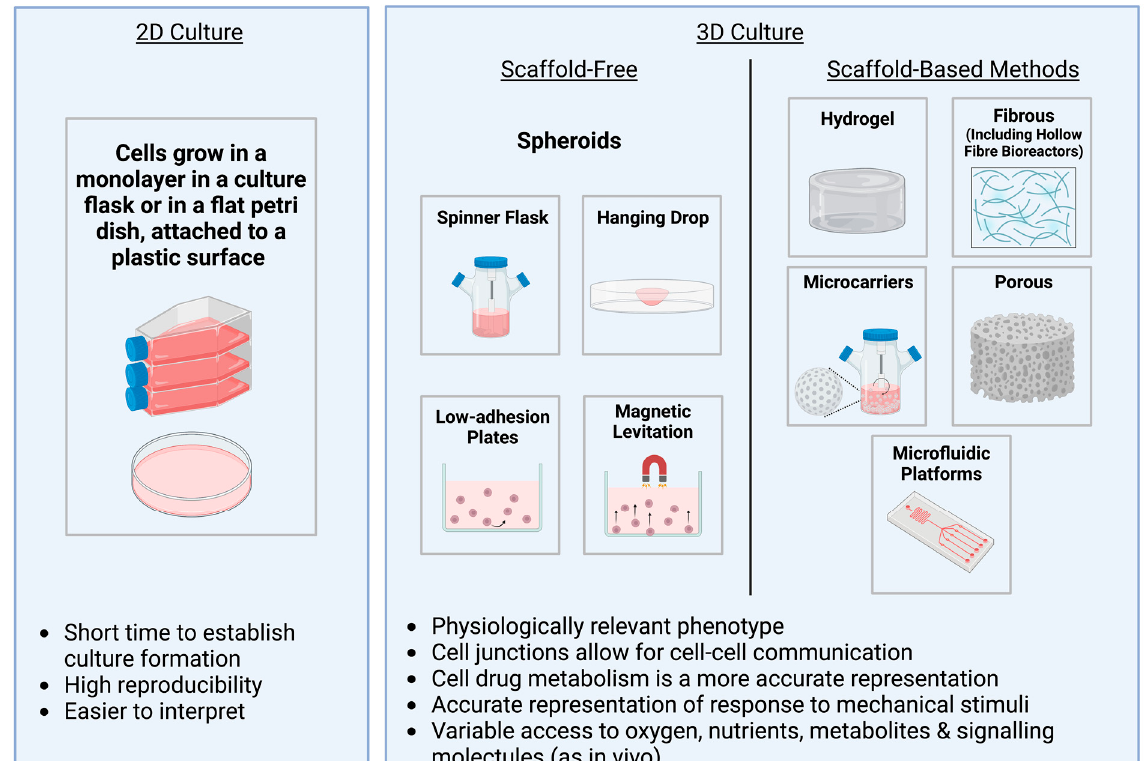
Figure 3. Advantages of 2D and 3D culture methods and the different types of 3D culture ap- proaches.